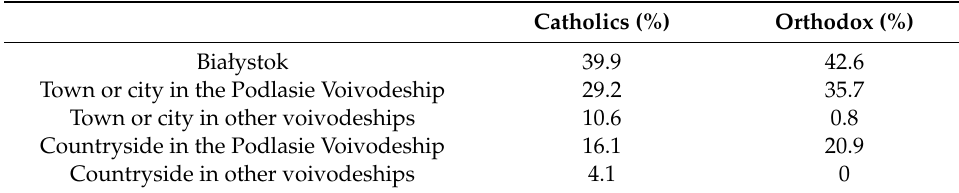
Table 5. Place of residence of the surveyed students.